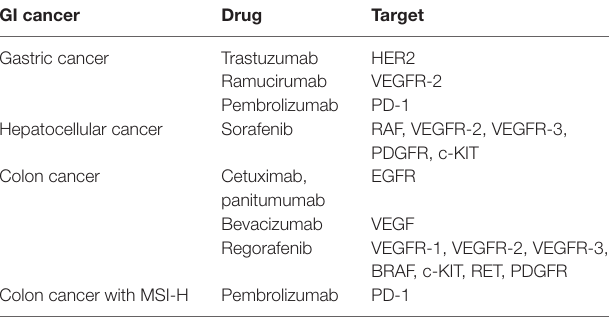
TAble 3 | Approved targeted therapies for GI